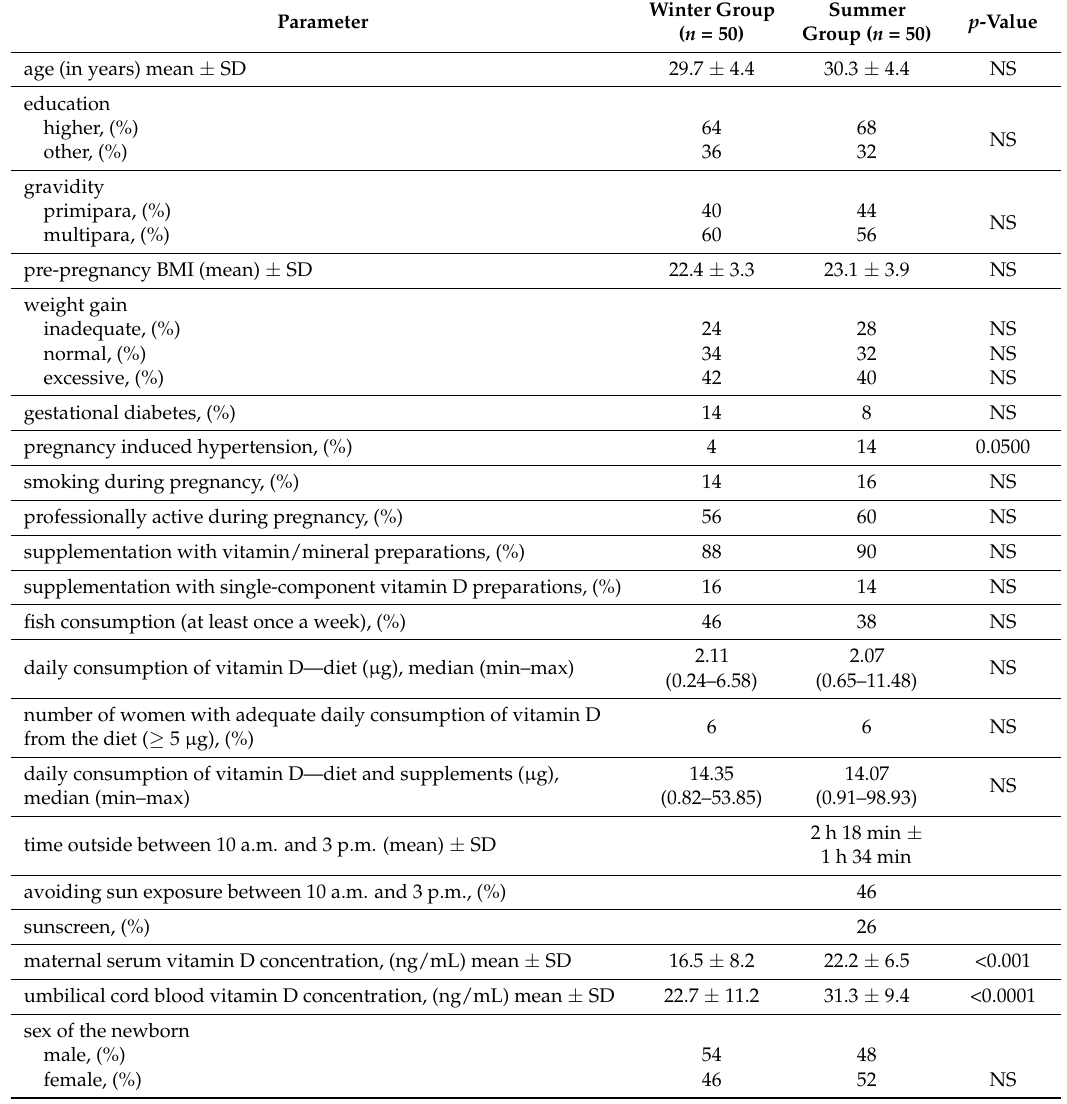
Table 1. Maternal